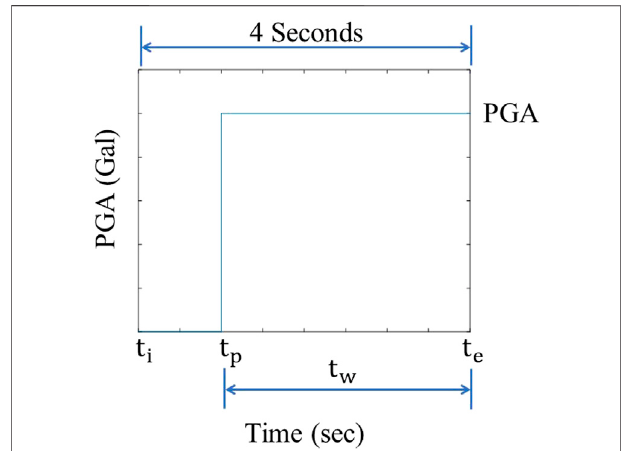
FIGURE 2 | The schematic diagram of the target output of the LSTM model. t p is the P-wave arrival time; t i and t e are start time and end time, respectively; and t w is the length of the time-window between t p and t e